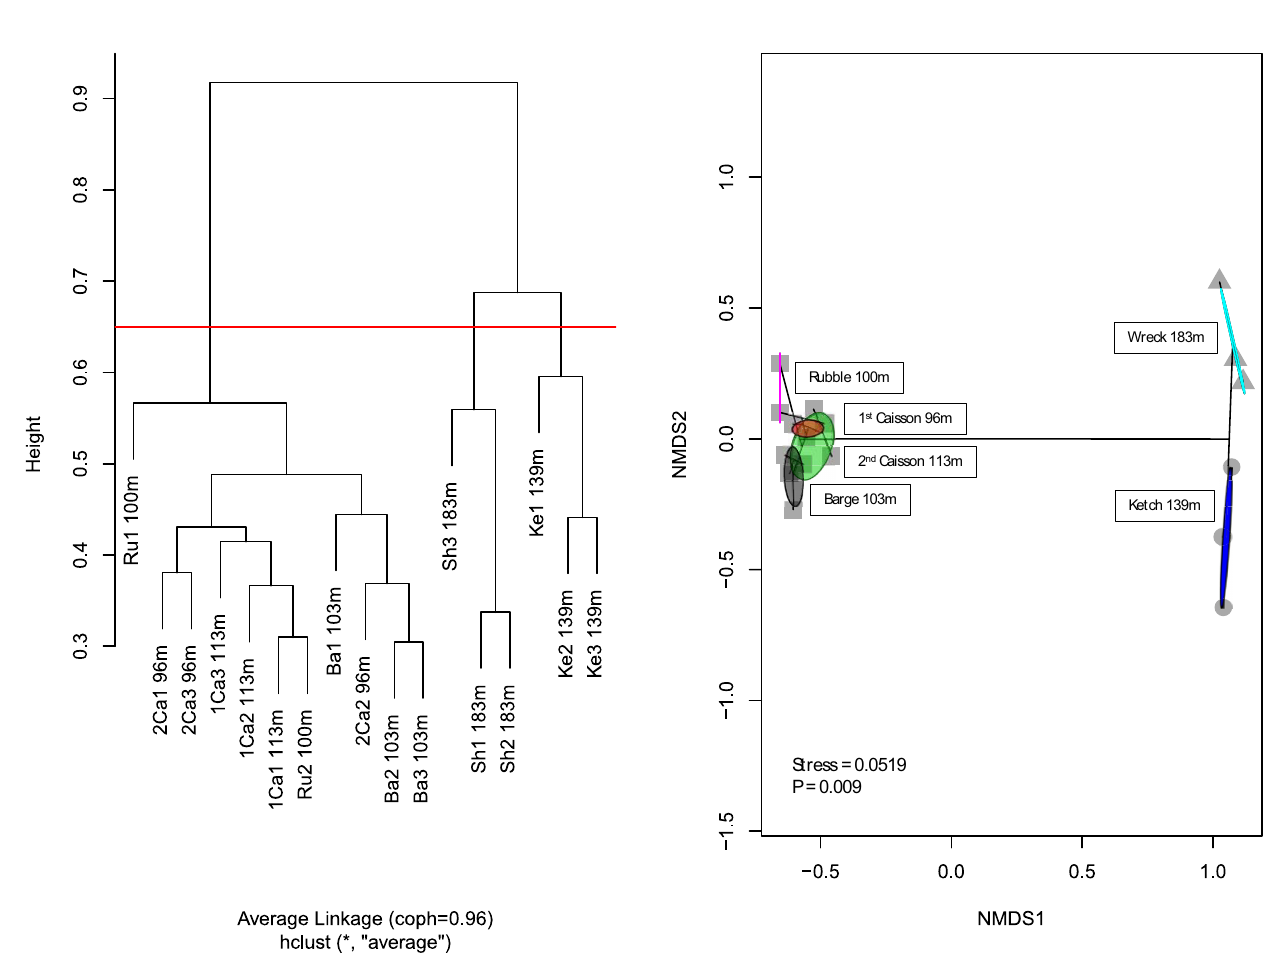
Fig 3. Biodiversity distribution across artificial features. Hierarchical clustering (Panel A) and nMDS (Panel B) both show significant differences between features either side of 130 m. At right, each observation is plotted in relation to the others based on the relative similarities between their observed species compositions, with observations grouped according to feature (colored ellipses), bridged hierarchically (black lines) according to Panel A, and designated according to cluster in Panel A at height h = 1 (gray symbols).